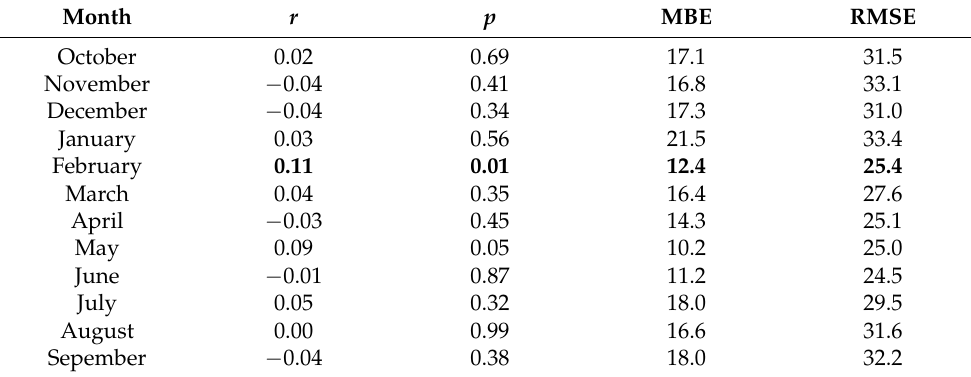
Table 3. Verification statistics for the average number of low flow events calculated from the NWM retrospective simulations relative to associated USGS observations at river segments with a Strahler stream order ≥ 4. Months where the Spearman correlation coefficient is significant at p < 0.05 are in